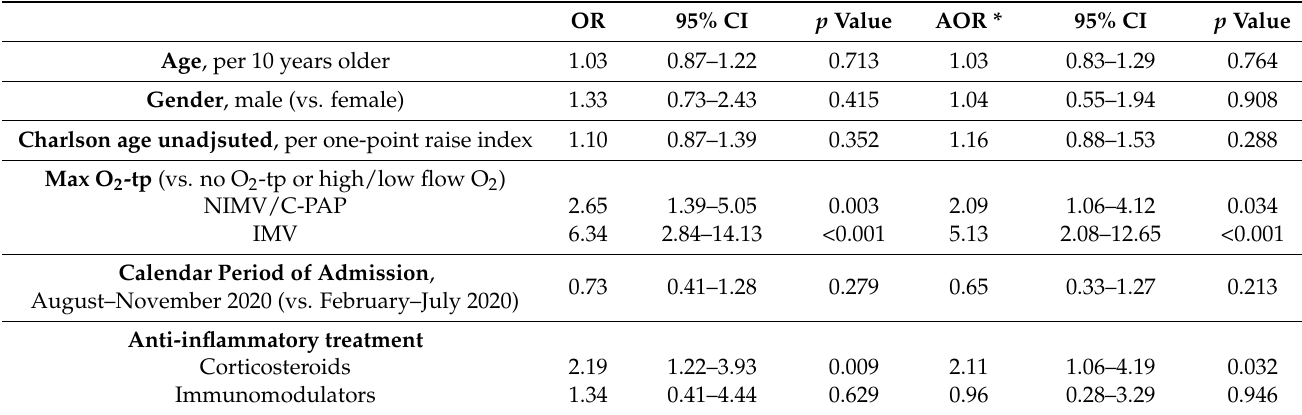
Table 4. Uni- and multi-variable analysis of risk factors for the development of hospital acquired BSI during hospitalisation for COVID-19.